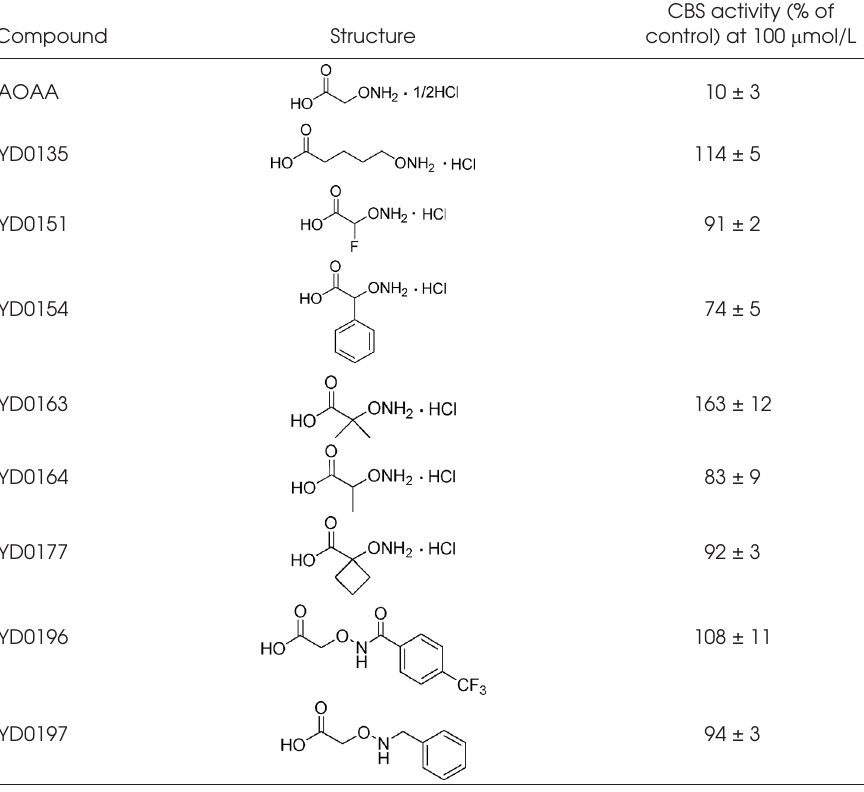
Table 1. Effect of covalent modifications of AOAA on recombinant CBS activity in vitro